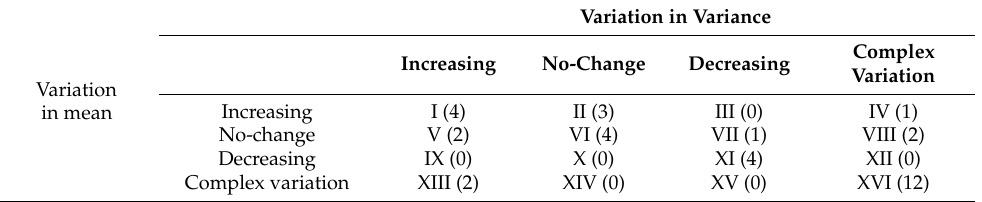
Figure 5. Variations of quantile curves (0.95, 0.75, 0.5, 0.25, and 0.05 from top to bottom) of 1DMIN (annual minimum 1-day streamflow) at ( a ) H2 (Xiayun), ( b ) H3 (Sanxia), ( c ) H5 (Xiulang), and ( d ) H7 (Wudu). Table 7. Definition of the 16-category distributional changes and the corresponding number of flow indices belonging to each